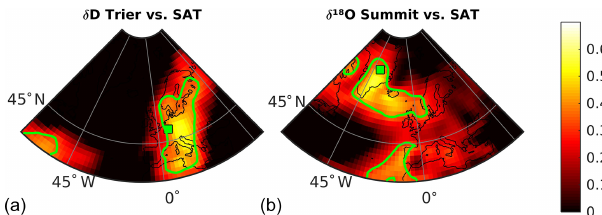
Figure 4. (a) Correlation map between annual δ D in precipitation from the Trier station (green square; IAEA/WMO, 2016) and an- nual surface air temperatures in the NOAA–CIRES 20th climate re- analysis V2c (Compo et al., 2011) for the period 1978–2011CE. (b) Same as (a) but for δ 18 O from the GISP2 ice core (green square; Steig et al., 1994; White et al., 2009) and for the period 1950–1986CE. Green contour lines represent significance levels for p < 0 . 1 ( t test). The difference in years selected arises from the dif- ferent time span of the δ D and δ 18 O records used